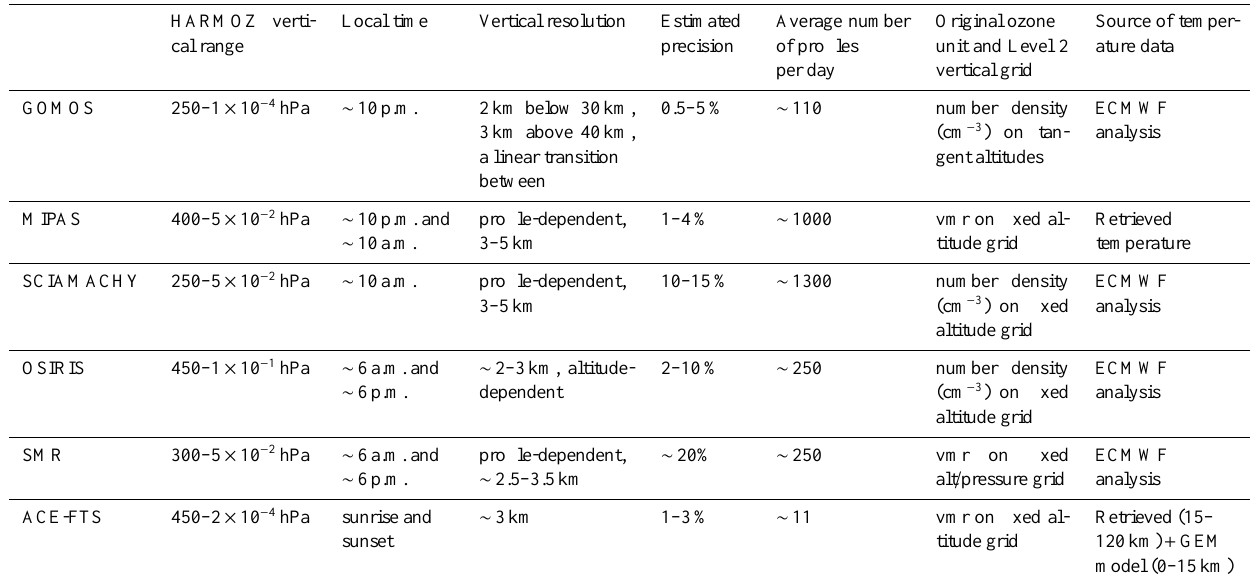
Table 1. General information about the datasets. Note that the average number of profiles per day is estimated from the average yearly volume, thus the number of profiles in each particular day can di ff er significantly from these average estimates.